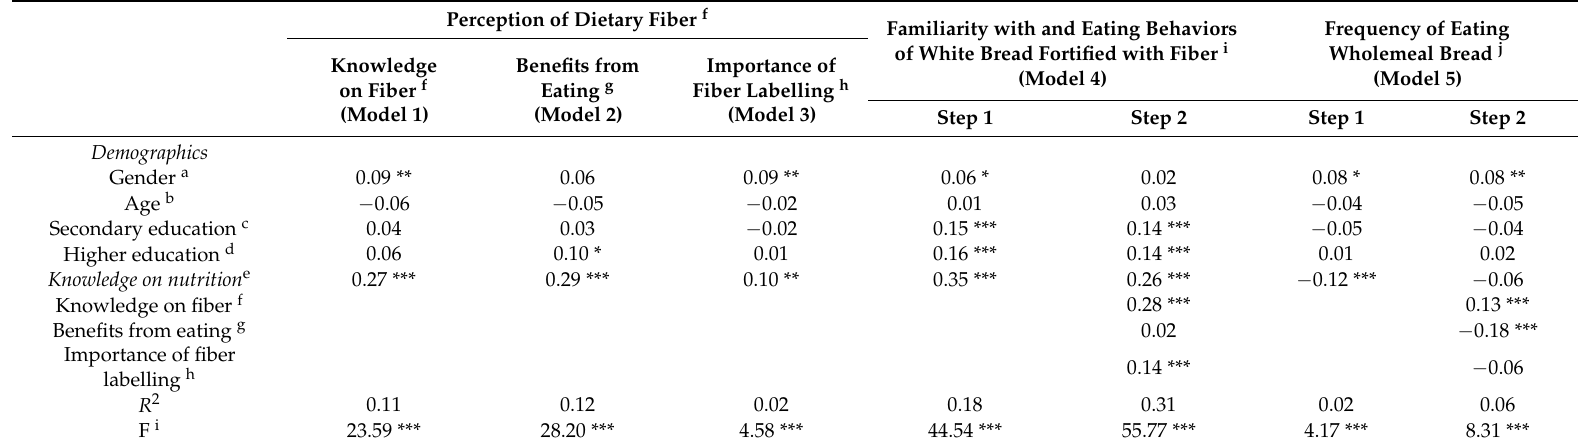
Table 3. Summary of results from multiple regression analysis testing the mediation of perception of dietary fiber when predicting eating frequency of white bread fortified with fiber and wholemeal